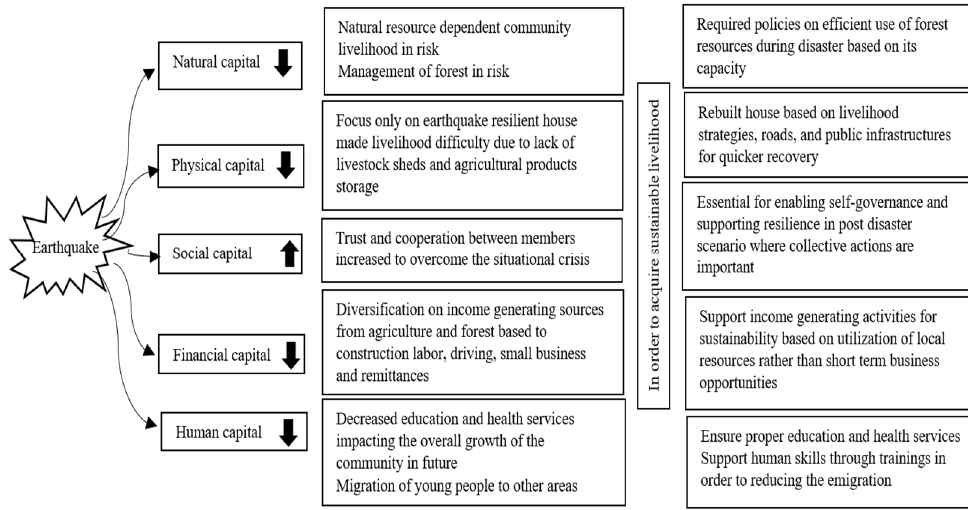
Figure 5. Conceptual diagram representing impacts of the earthquake on livelihood capital assets and options for sustainable livelihoods in the study